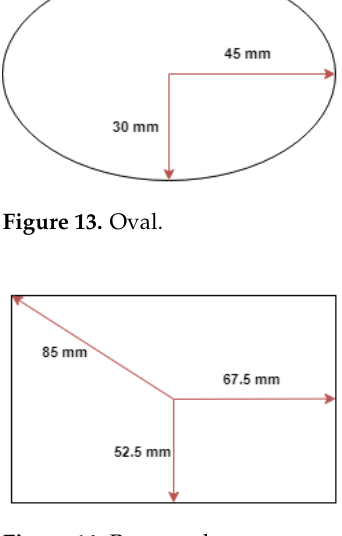
Figure 12. Circular.